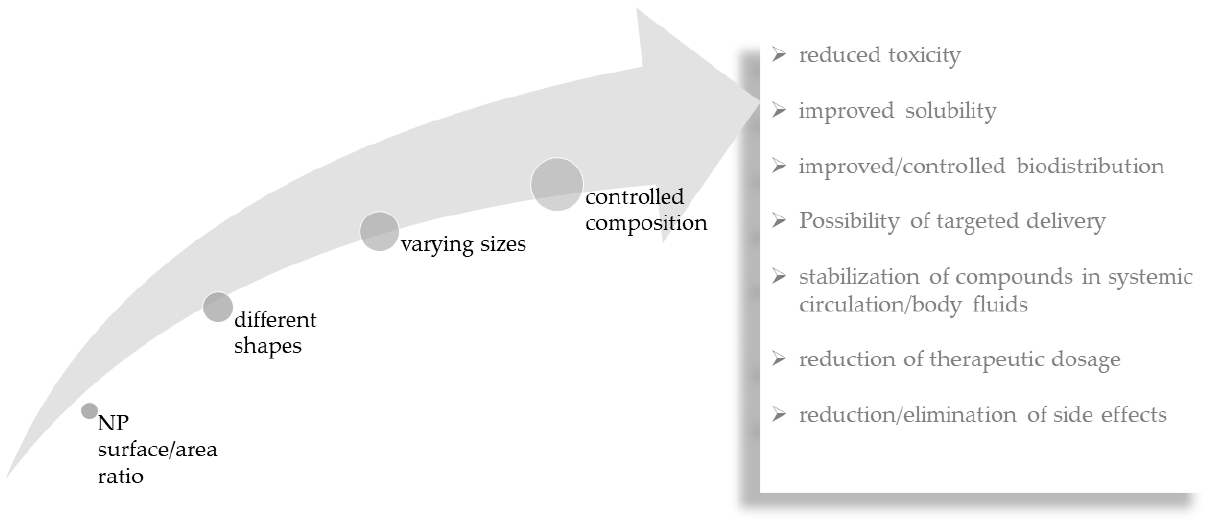
Figure 3. Relationship between important nanoparticle (NP) features and advantages of nanoparticle-mediated delivery of compounds.